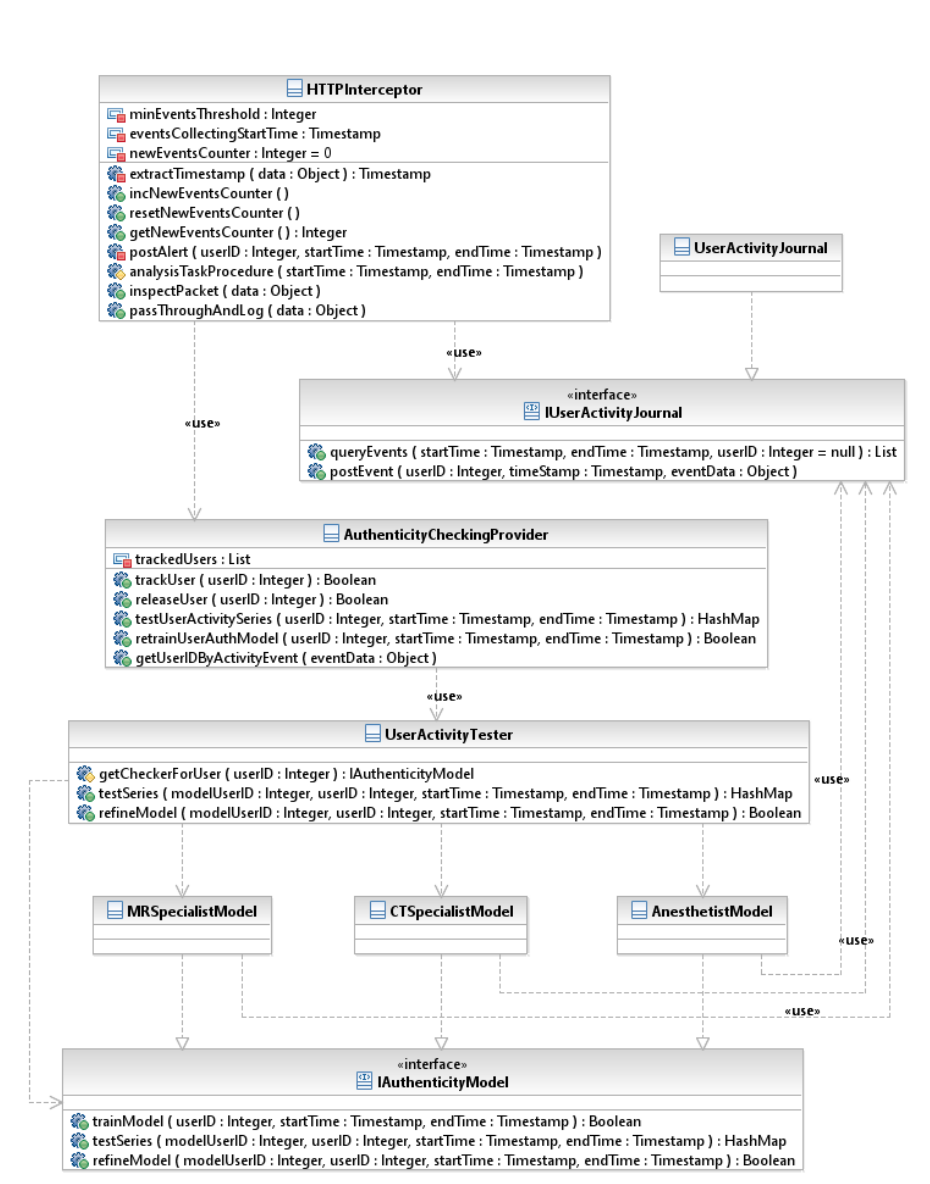
Figure 5. Class diagram of the component for user behavior analysis.